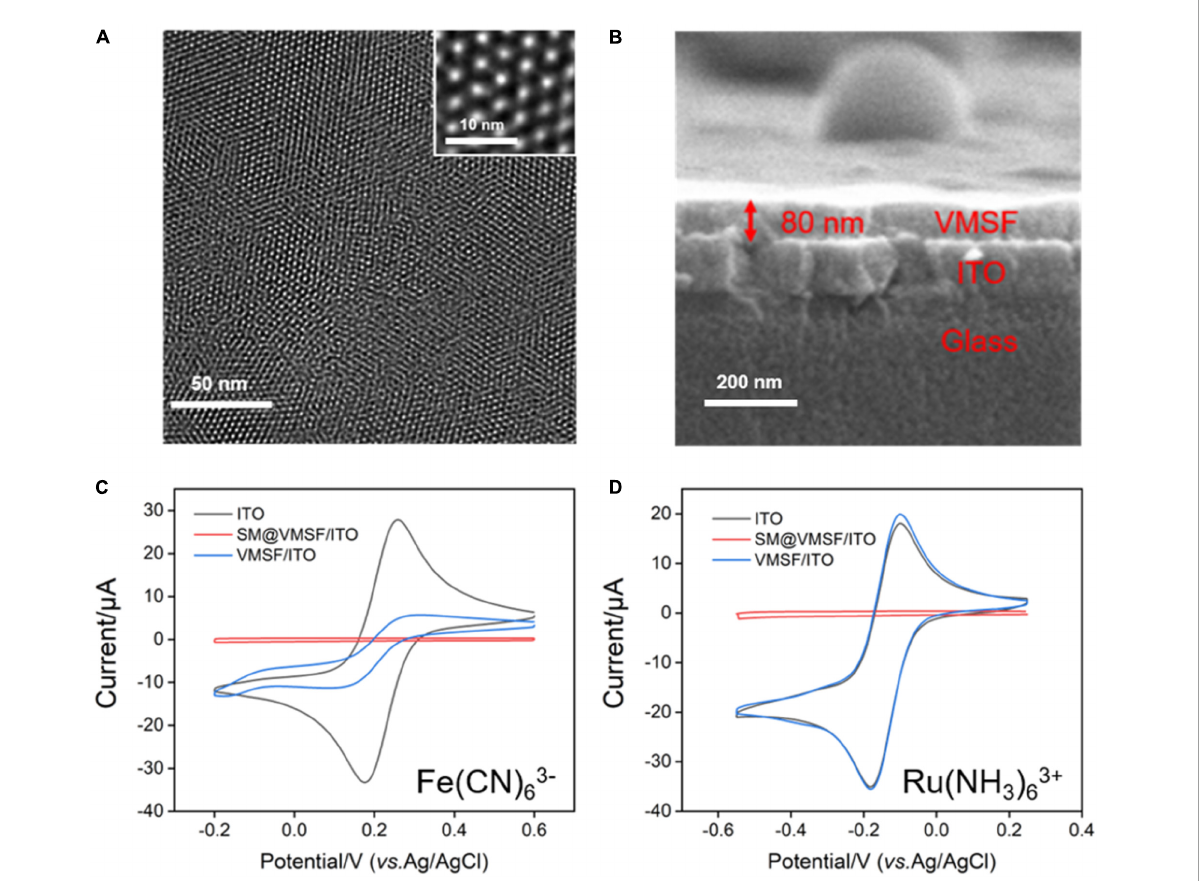
FIGURE1 (A) Top-view TEM and (B) cross-sectional view SEM images of VMSF. The inset in (A) is the corresponding magnified image. CV curves obtained at the bare ITO, SM@VMSF/ITO, and VMSF/ITO electrodes in 0.05 M KHP containing 0.5 mM K 3 Fe(CN) 6 (C) or Ru(NH 3 ) 6 Cl 3 (D) . The scan rate was 50 mV/s.